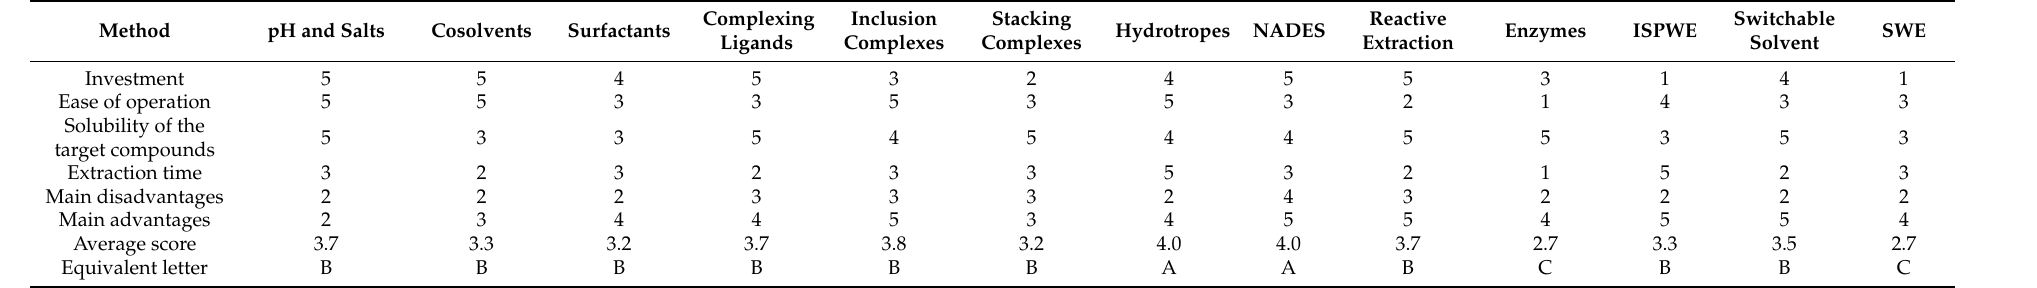
Table 3. Details about the rating given to every criterion of each